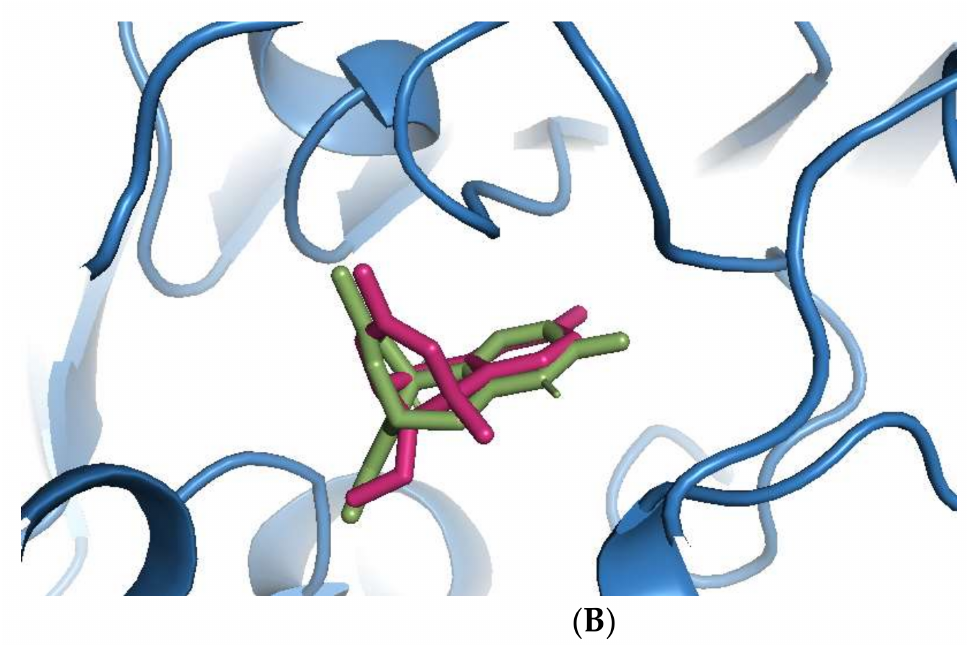
Figure 1. Binding of phytochemicals at different sub-sites of the AChE active site. ( A ) Superimposition of docked sanguinarine (green-colored sticks) and pre-bound ligand huperzine A (pink-colored sticks) to the active site in the human AChE crystal structure (PDB ID: 4EY5). ( B ) Superimposition of docked huperzine A (green-colored sticks) and pre-bound ligand huperzine A (pink-colored sticks) in the human AChE crystal structure (PDB ID: